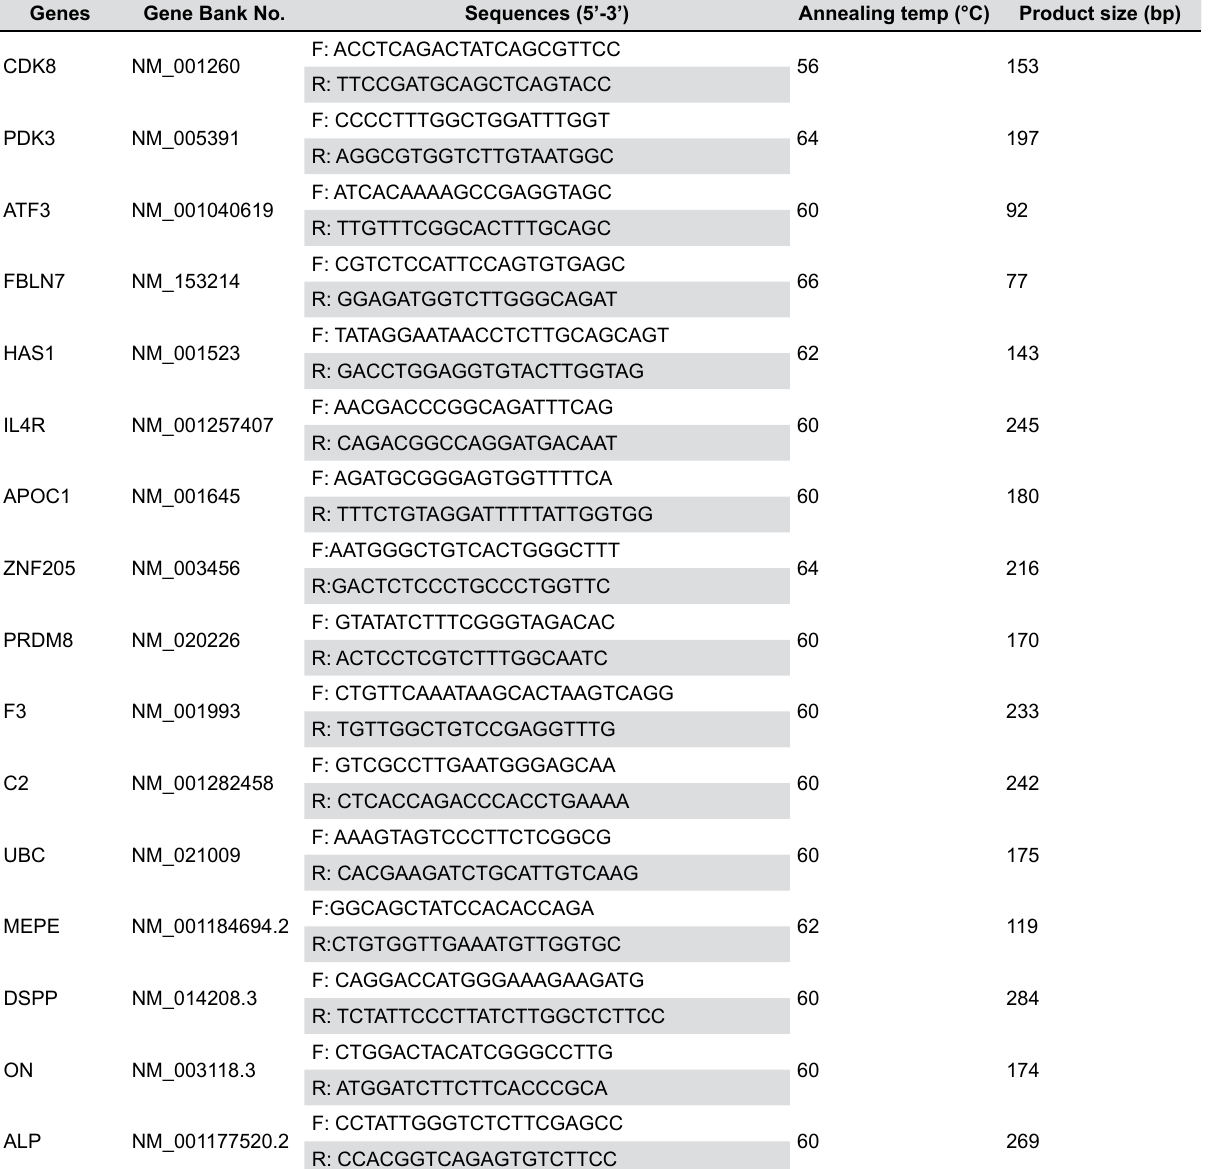
Table S1- The primer sequences for the selected